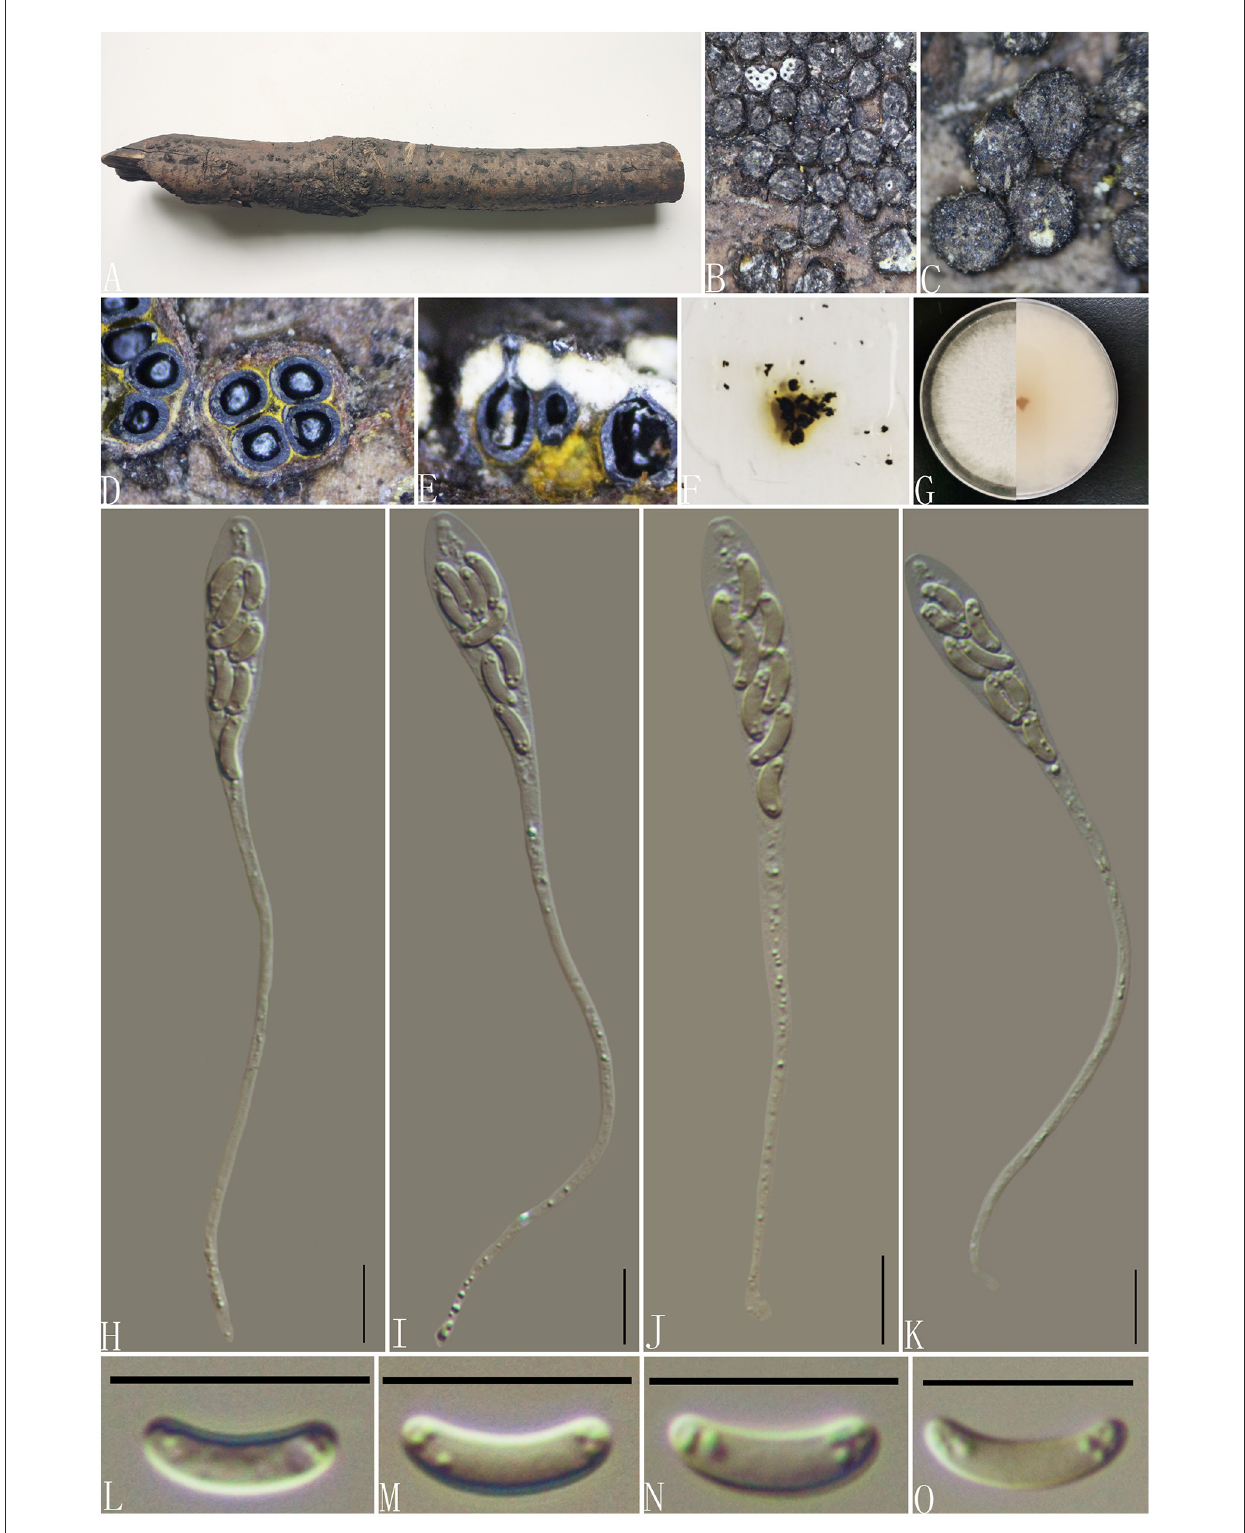
FIGURE7 Diatrype enteroxantha (GMB0433). (A) Material. (B, C) Close-up of stromata. (D) Transverse section through stromata. (E) Vertical section through stromata. (F) Pigments in KOH. (G) Culture on PDA. (H–K) Asci. (L–O) Ascospores. Scale bars: (H–O) = 10 µ